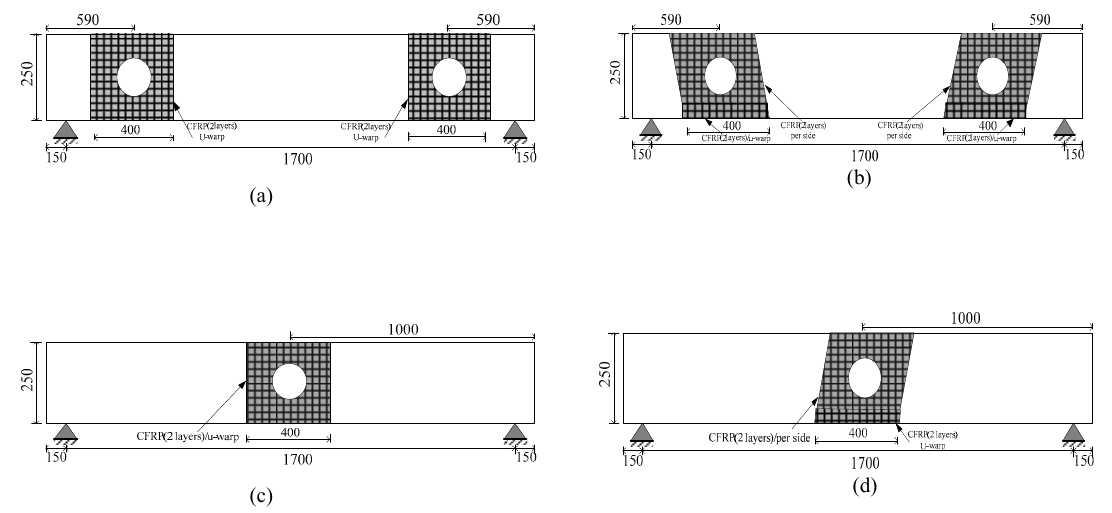
Figure 2. Details of strengthened beams with CFRP orientation: ( a ) vertical u-warp, elevation of BC-3, ( b ) inclined u-warp, elevation of BC-4, ( c ) vertical u-warp, elevation of BC-5, ( d ) inclined u-warp, elevation of BC-6. Note: all dimensions in mm.